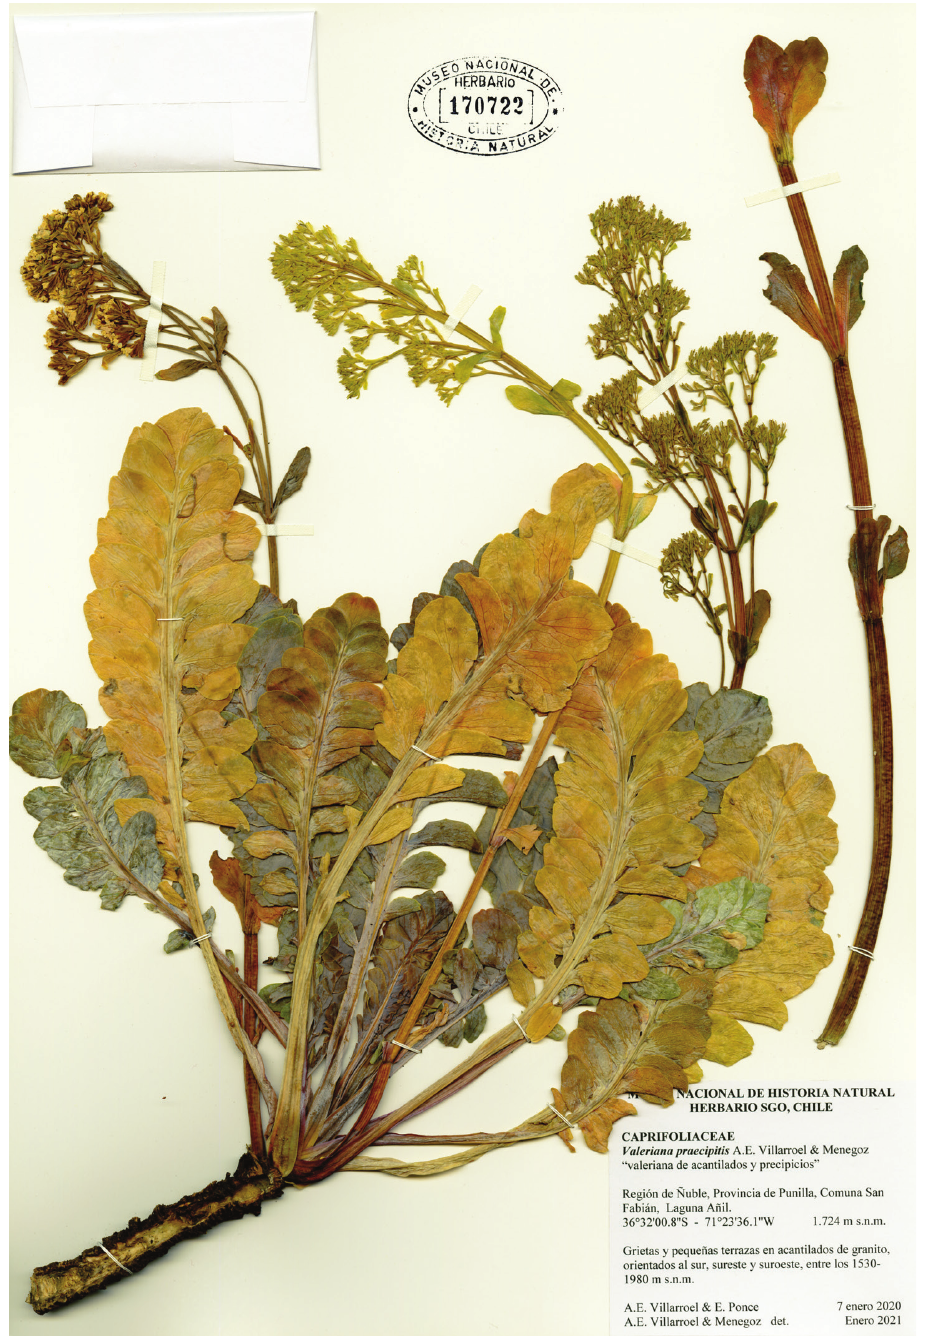
Figure 2. Holotype of Valeriana praecipitis